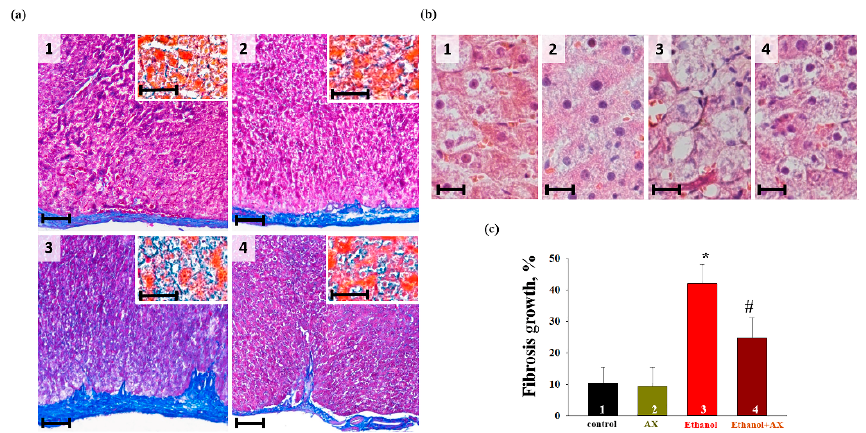
Figure 1. Histological samples of liver tissue in rats of the control and experimental groups. ( a )—Fragments of histotopograms of periportal areas of rat liver tissue. Light microscopy; main images—Masson’s trichrome stain (collagen/fibrosis—blue, non-collagen components—pink, cell nuclei—dark crimson), ruler 100 µm; Inserts—Malory trichrome stain (collagen/fibrosis—blue, non-collagen components—orange/red, cell nuclei—red), ruler 50 µm; ( b )—Photomicrographs of perivascular rat liver hepatocytes. Light microscopy; H&E (cell nuclei in purple, erythrocytes in red, cell cytoplasm in pink), ruler 20 µm; ( c ) is a diagram showing the growth of deposited collagen in the periportal region of the liver of each group of rats. The data are presented as the means ± SD of three independent experiments. * p < 0.05 significant difference in the protein levels in comparison with the control (group 1). # p < 0.05 compared to RLM isolated from ethanol-administrated rats (group 3). The statistical significance of the differences between the pairs of mean values was evaluated using the Student–Newman–Keul test.